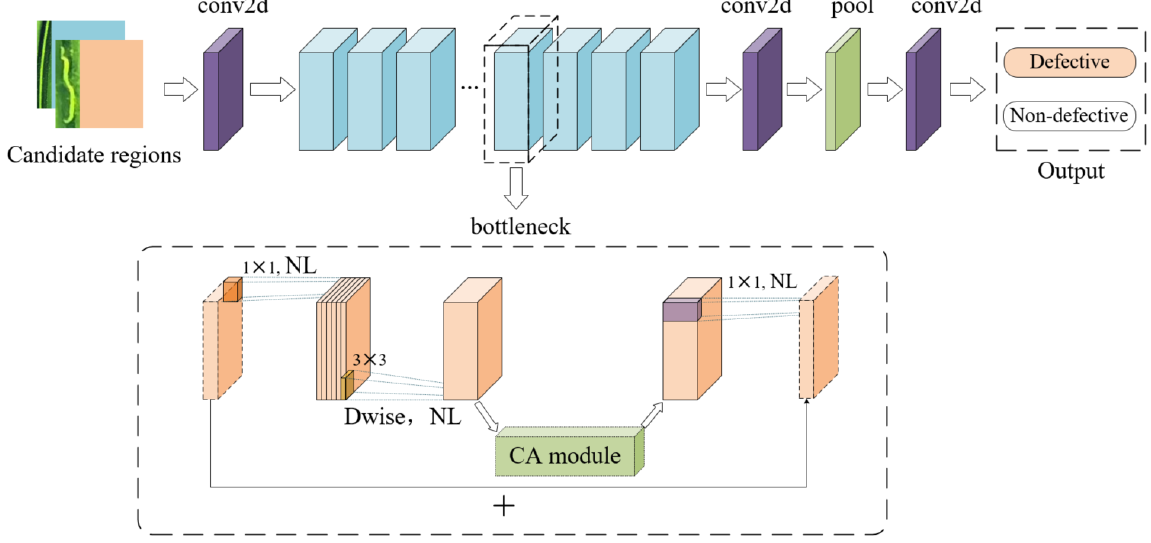
Figure 7. Network architecture of the improved MobileNetV3. The operation and parameter details of each layer in the improved MobileNetV3 is described in Table 1. Input represents the size of the input feature map. Operator represents the type of each layer in the network. Kernel size refers to the size of the convolution kernel or pooling kernel applied in each operator, and stride is the step size of the convolution or pooling operation. Out denotes the dimension of the output feature map by the